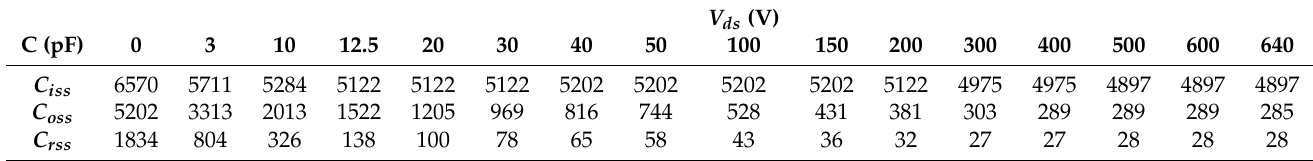
Table 4. SiC MOSFET capacitance table for V ds voltage at 25 ◦